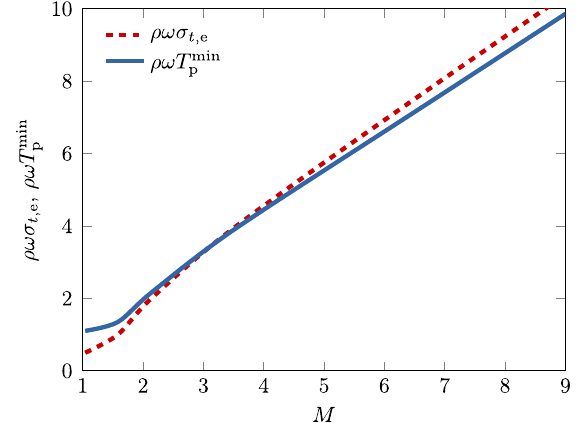
FIG. 4. Normalized rms electron bunch length (cid:8)!(cid:4) t; e contrib- uting to the FEL process (red dashed line) and the corresponding normalized minimum FWHM radiation pulse duration (cid:8)!T min p (blue solid line) at the end of the exponential gain regime ( s=L sat & 0 : 8 ) versus the number of modes M .